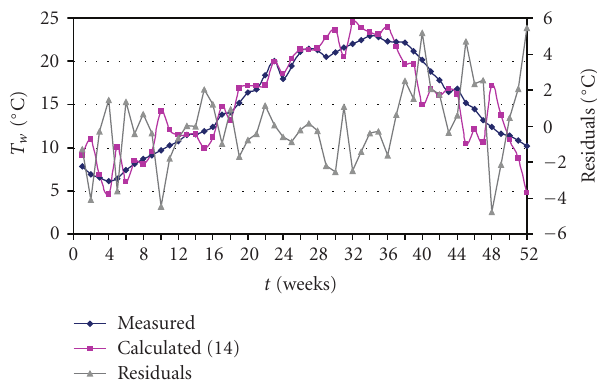
Figure 10: Comparison between measured and estimated data (13), correlation coe ffi cient r Tw , Tw 1 = 0 . 9091.